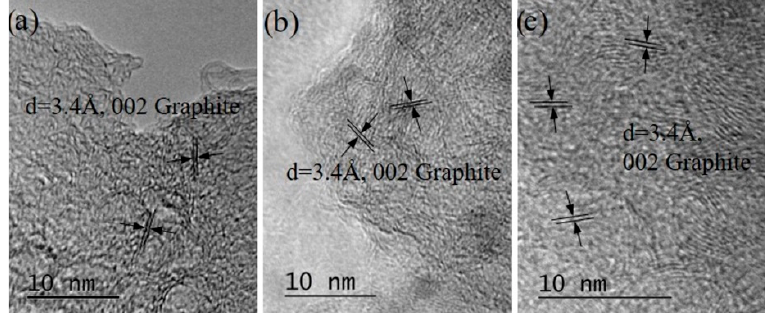
Figure 10. ( a ) HRTEM image of bundles of 3–7 layered graphene/defected graphene obtained by PLAL ( λ = 266 nm irradiation) of a suspension of LQ graphite in 6% H 2 O 2 in bidistilled water. ( b ) HRTEM image of bundles of 1-5 layered graphene/defected graphene obtained by PLAL ( λ = 355 nm irradiation) of a suspension of HQ graphite in 6%H 2 O 2 in bidistilled water. ( c ) HRTEM image of bundles of 3–5 layered graphene/defected graphene obtained by PLAL ( λ = 266 nm irradiation) of a suspension of LQ graphite in 6% H 2 O 2 in bidistilled water.